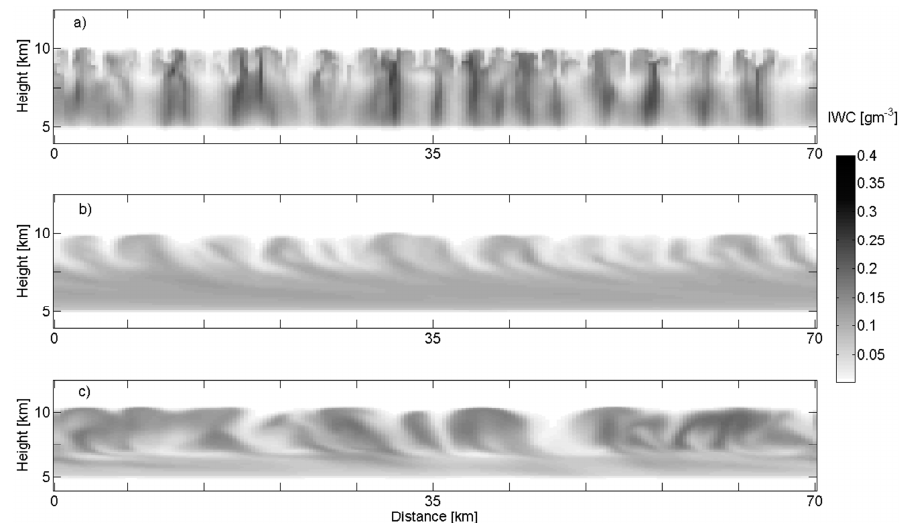
Figure 14. 2-D vertical slice of 3DCLOUD ice water content (IWC gm 3 ) through a 3-D simulation at an angle parallel to the wind (a) RC99a case, (b) RC99 case and (c) RC99b case. Fields are obtained from simulations where N x = N y = 200 and N z = 66 and 1 x = 1 y = 250m and 1 z = 120m. Horizontal extensions are L x = L y = 50km and vertical extension is L z = 8km between 4km and 12km. Note that the 3DCLOUD fields are smooth because obtained at the first step of the algorithm.